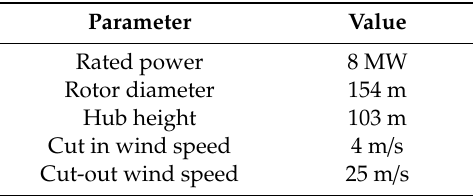
Table 7. Technical data wind turbine